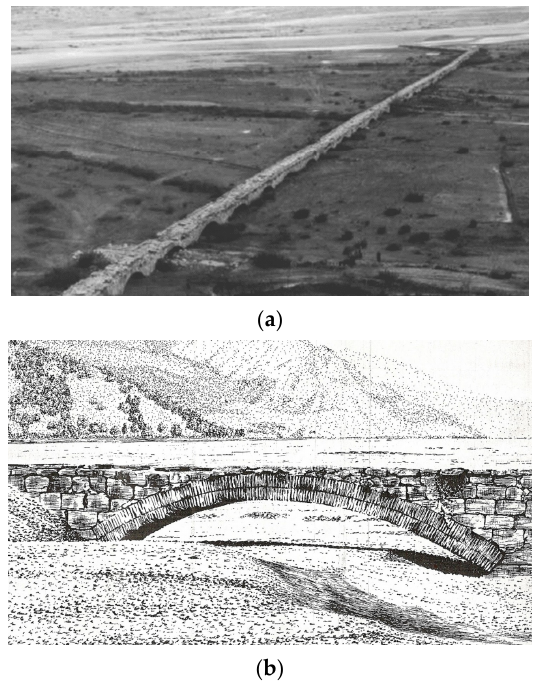
Figure 9. Limyra bridge (Turkey): Overview ( a ); Single arch sketch ( b ) [34].